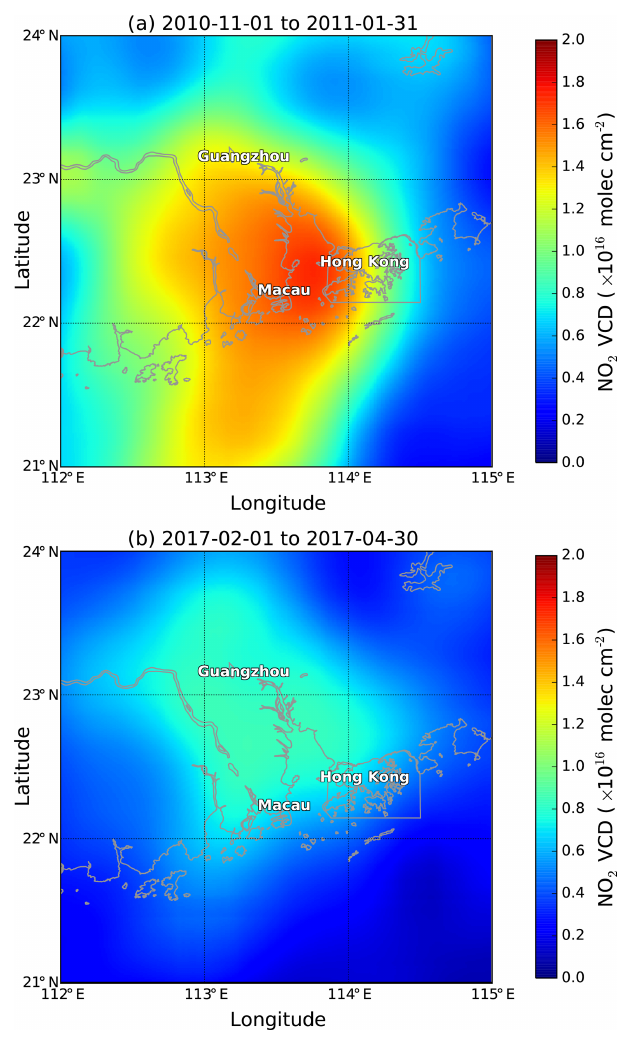
Figure 7. Averaged OMI tropospheric NO 2 VCDs over Pearl River delta (a) from 1 November 2010 to 31 January 2011 and (b) from 1 February 2017 to 31 April